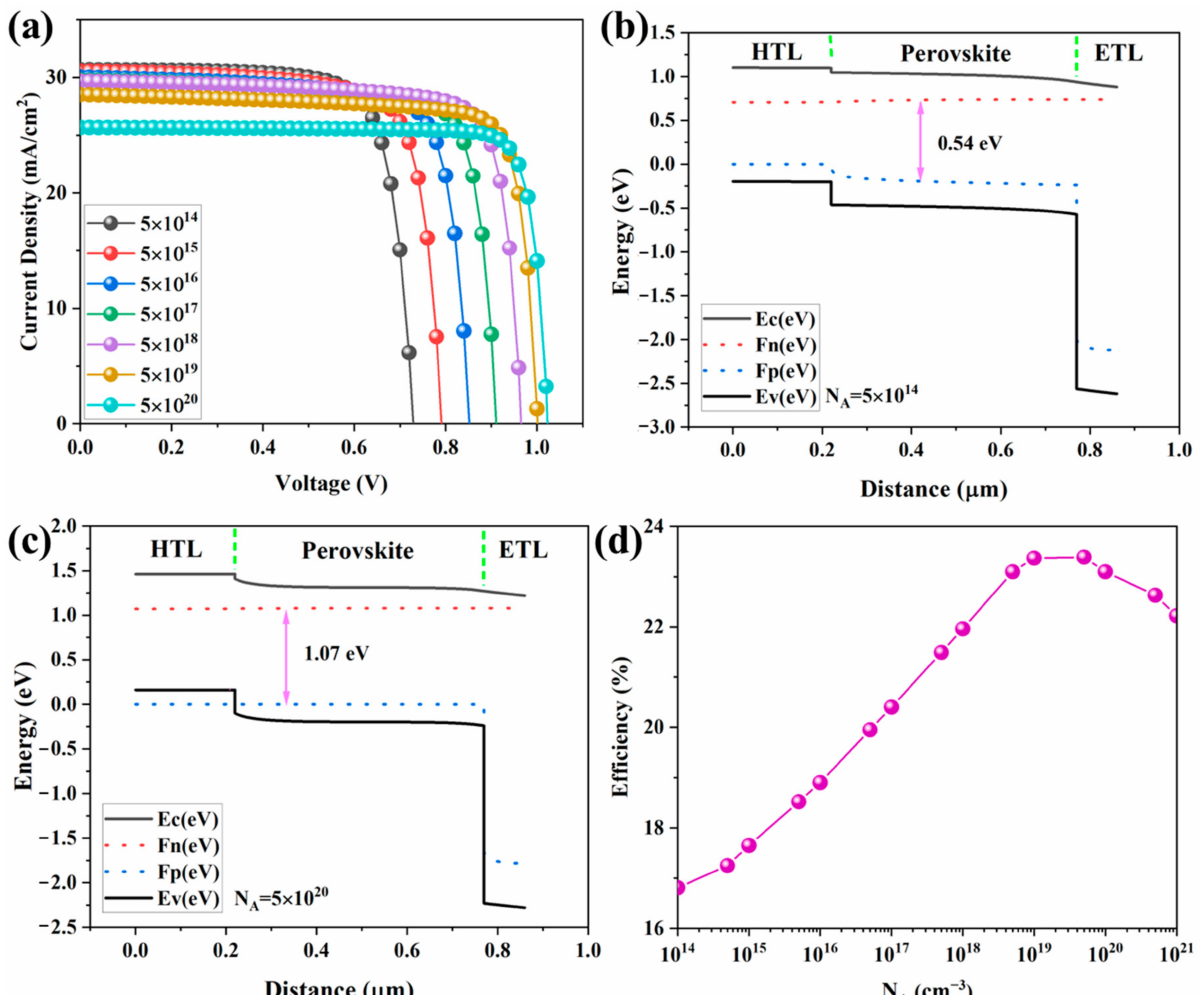
Figure 5. ( a ) J-V curves of perovskite solar cells depending on the doping density of the CsSnI 3 layer. ( b , c ) Band diagram of the cells at the doping densities of 5 × 10 14 and 5 × 10 20 cm − 3 . ( d ) Effect of doping density on